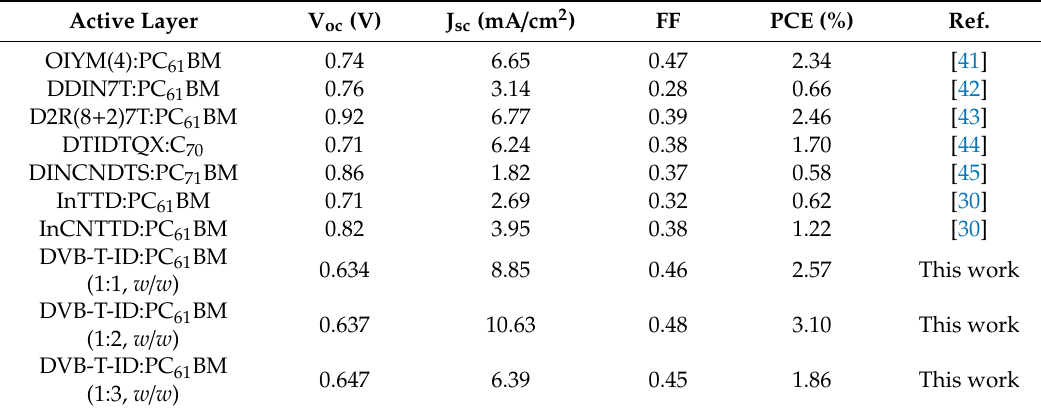
Table 2. Summary of photovoltaic parameters of the fabricated and reported